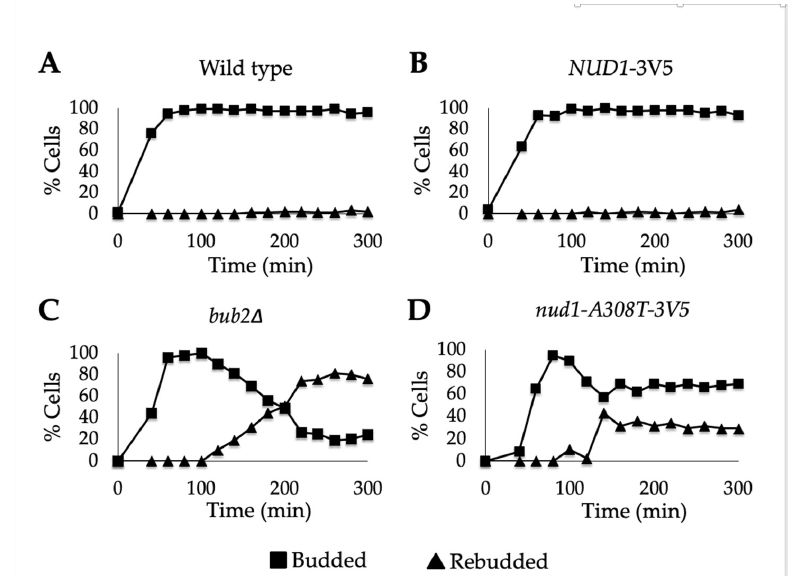
Figure 2. nud1-A308T partially bypasses the spindle assembly checkpoint (SAC). Log phase wild- type (AS3), NUD1-3V5 (AS326), bub2 Δ (AS112), and nud1-A308T (AS387) cells were arrested in the presence of alpha-factor pheromone (5 ug/mL) for a total of 3 h at 25 °C. Cells were then released into medium containing nocodazole (15 ug/mL) and samples were taken at the indicated times for budding analysis. After 120 min and 240 min, 7.5 ug/mL nocodazole was re-added to maintain the metaphase block. The percentage of budded (squares) and re-budded (triangles) cells observed at each time point in wild-type ( A ), NUD1-3V5 ( B ), bub2 Δ ( C ), and nud1-A308T-3V5 ( D ) cells was plotted ( n = 100).